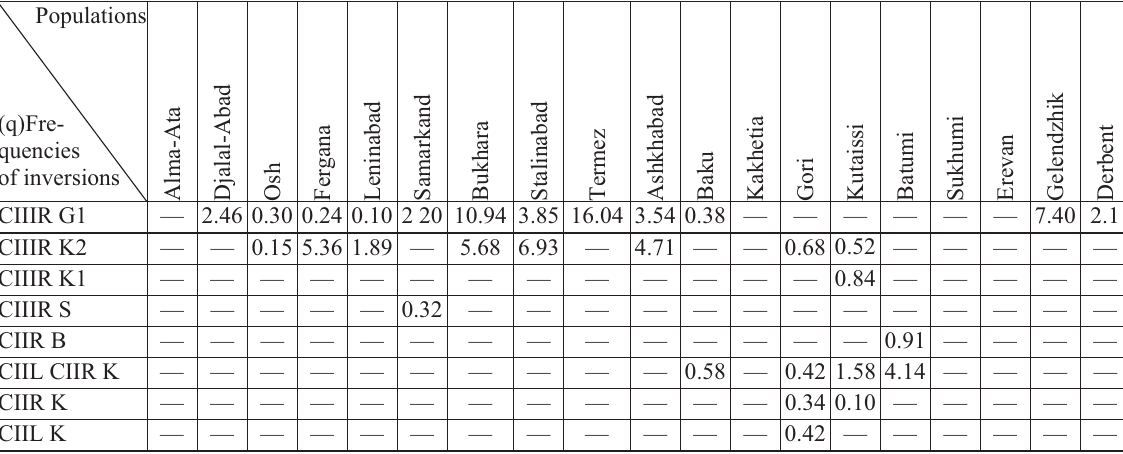
Table. Frequencies of various inversions in different populations of D. melanogaster (in per cent).